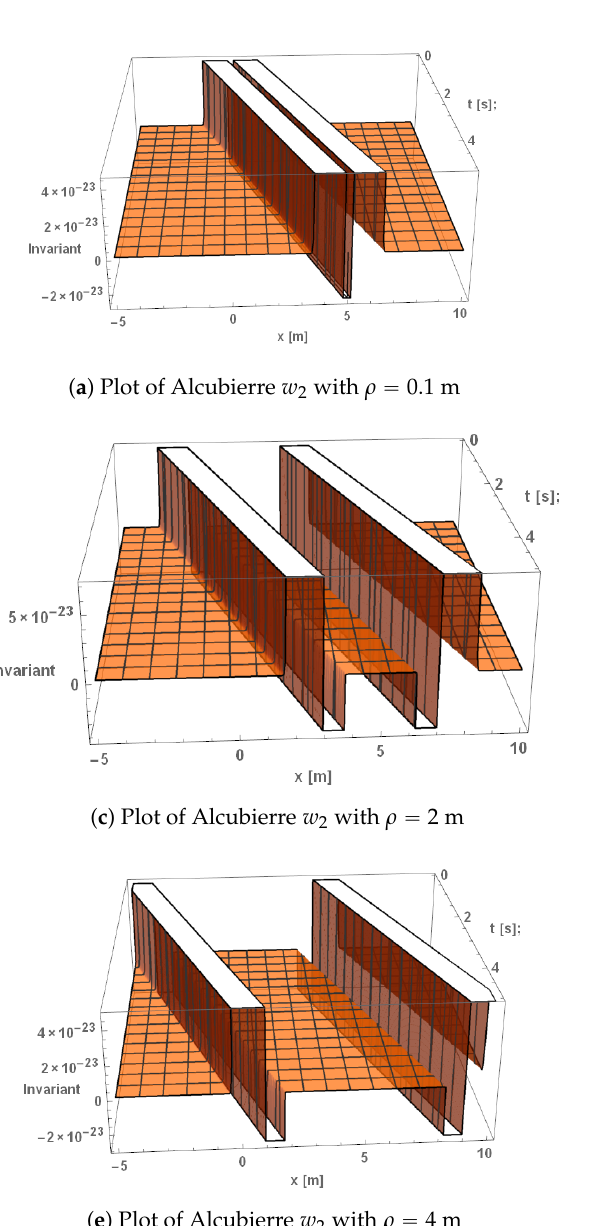
Figure A6. Plots of the w 2 invariants for the Alcubierre warp drive while varying radius. The other parameters were chosen as σ “ 8 m ´ 1 and v s “ 1 c to match the parameters Alcubierre originally suggested in his paper